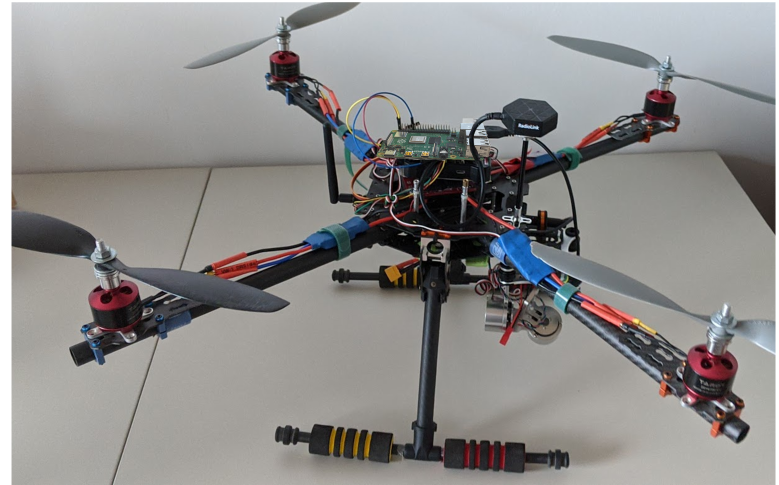
Figure 1. The air station of the UAV and WebRTC-based universal framework: the station stands on the laboratory